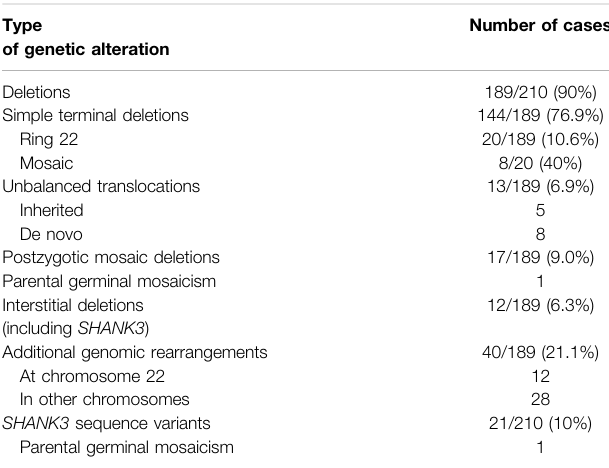
TABLE 3 | Summary of genetic fi ndings from the